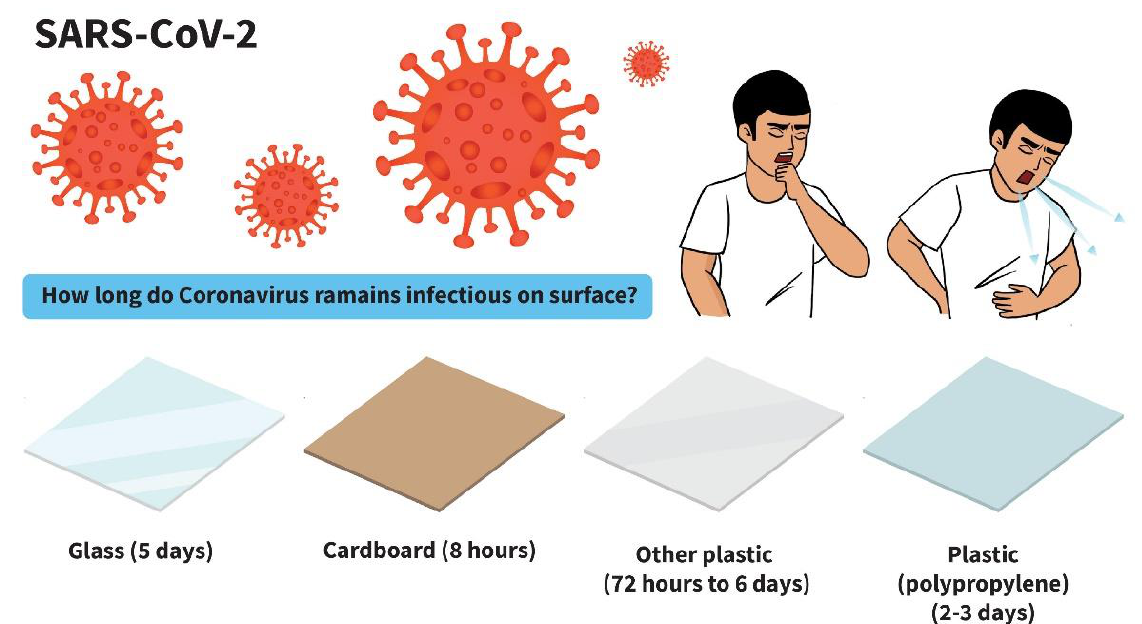
Figure 2. Contamination of SARS-CoV-2 viruses on packaging surface and transfer via touching the nose, mouth or eyes, which leads to disease spread more rapidly through human-to-human interactions, e.g., breathing, sneezing or coughing.